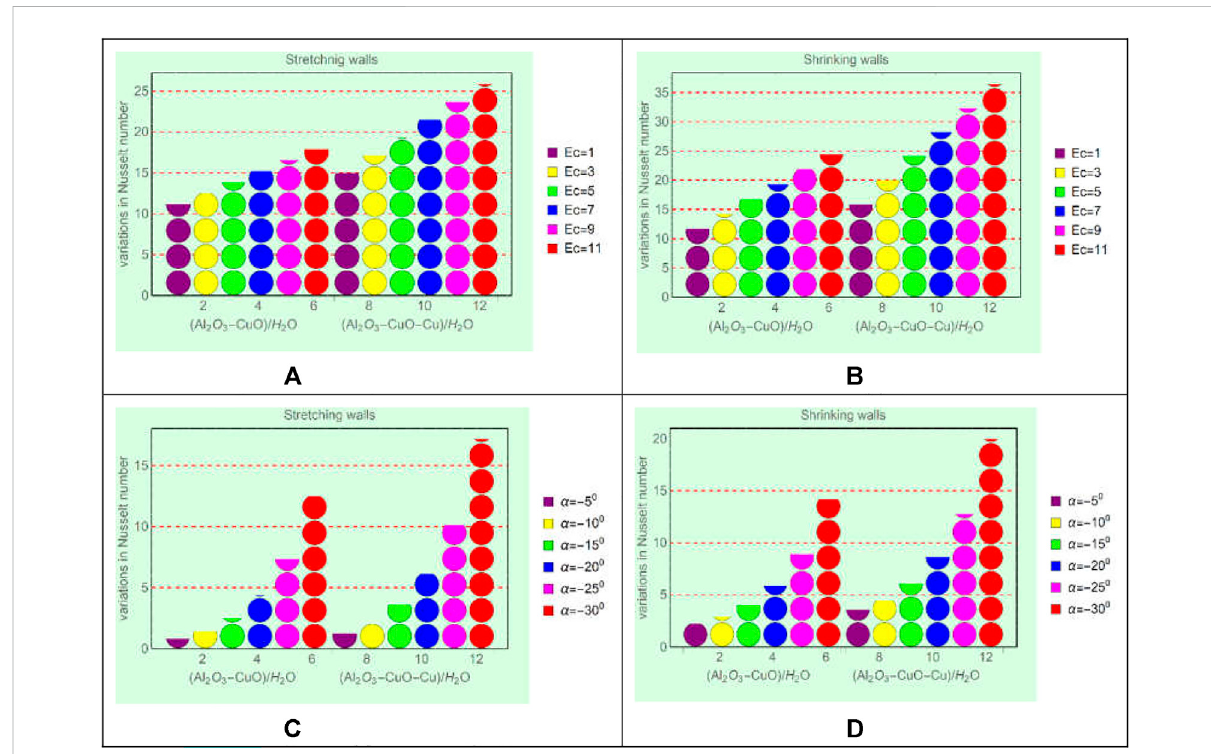
FIGURE 8 Local energy storage against (A) stretching and Ec, (B) shrinking and Ec, (C) stretching and α , and (D) shrinking and α .